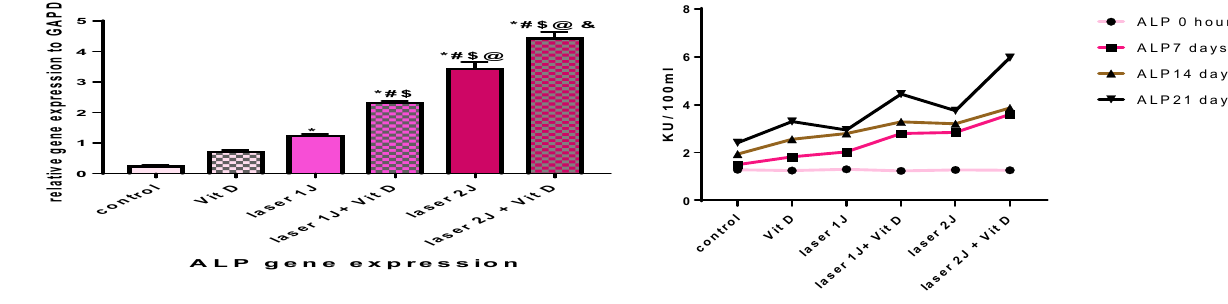
Figure 6: Alkaline phosphatase gene expression shows a statistically significant difference between all groups that in the control group (p < 0.0001), except for the vitamin D alone group. Data were expressed as mean ± SD; a p-value < 0.05 was significant. (*) denotes significant difference versus control. (#) denotes significant difference versus vitamin D. ($) denotes significant difference versus laser 1 J/cm 2 . (@) denotes significant difference versus laser 1 J/cm 2 + vitamin D. (&) denotes significant difference versus laser 2 J/cm 2 .